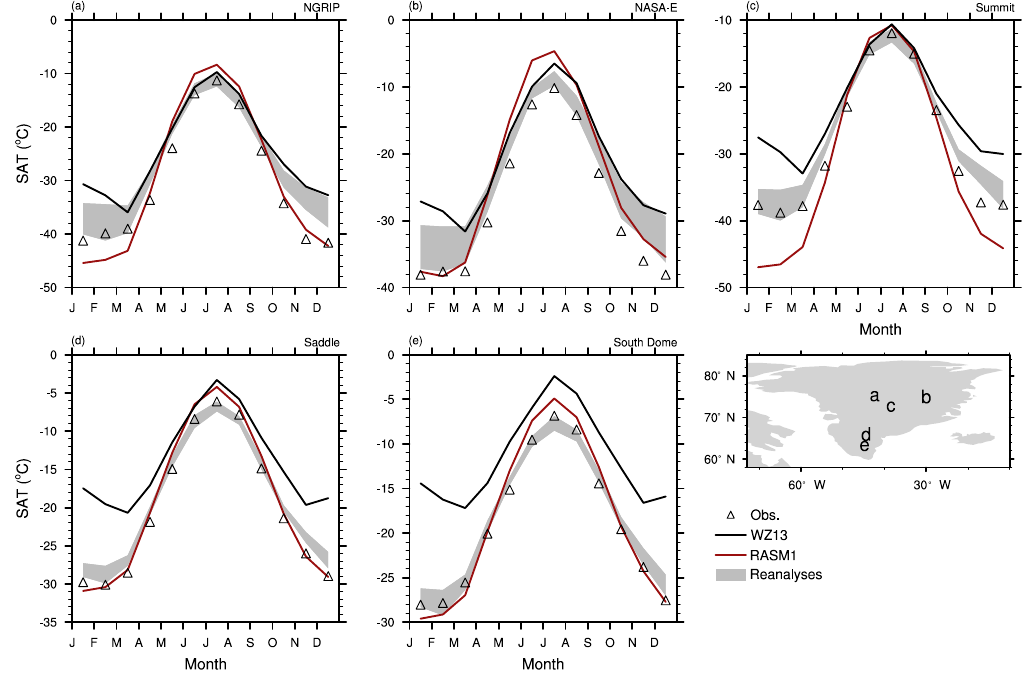
Figure 11. The mean annual cycle in 2m surface air temperature (SAT) observed at automated weather stations across Greenland along with those from the Wang and Zeng (2013, WZ13) dataset (black), RASM1 (red), and the spread in the reanalyses indicated by the gray shading at (a) NGRIP, (b) NASA-E, (c) Summit, (d) Saddle, and (e) South Dome. The locations of these sites are indicated in the map of Greenland.